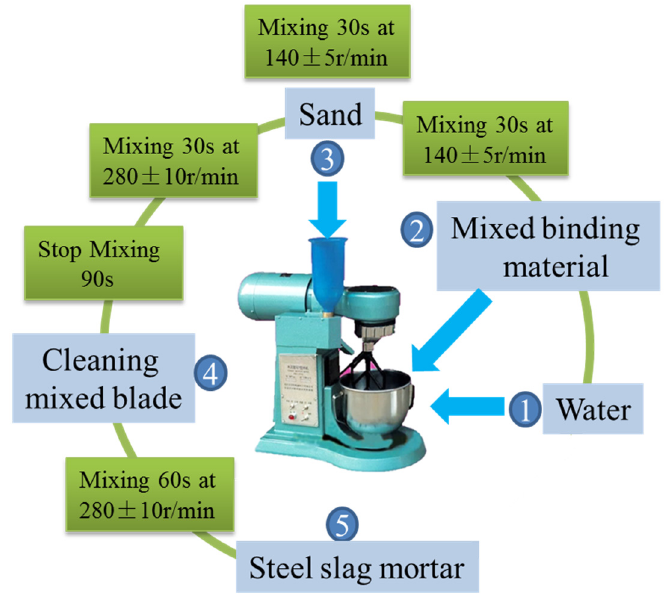
Figure 3. Mixing progress of steel slag mortar.